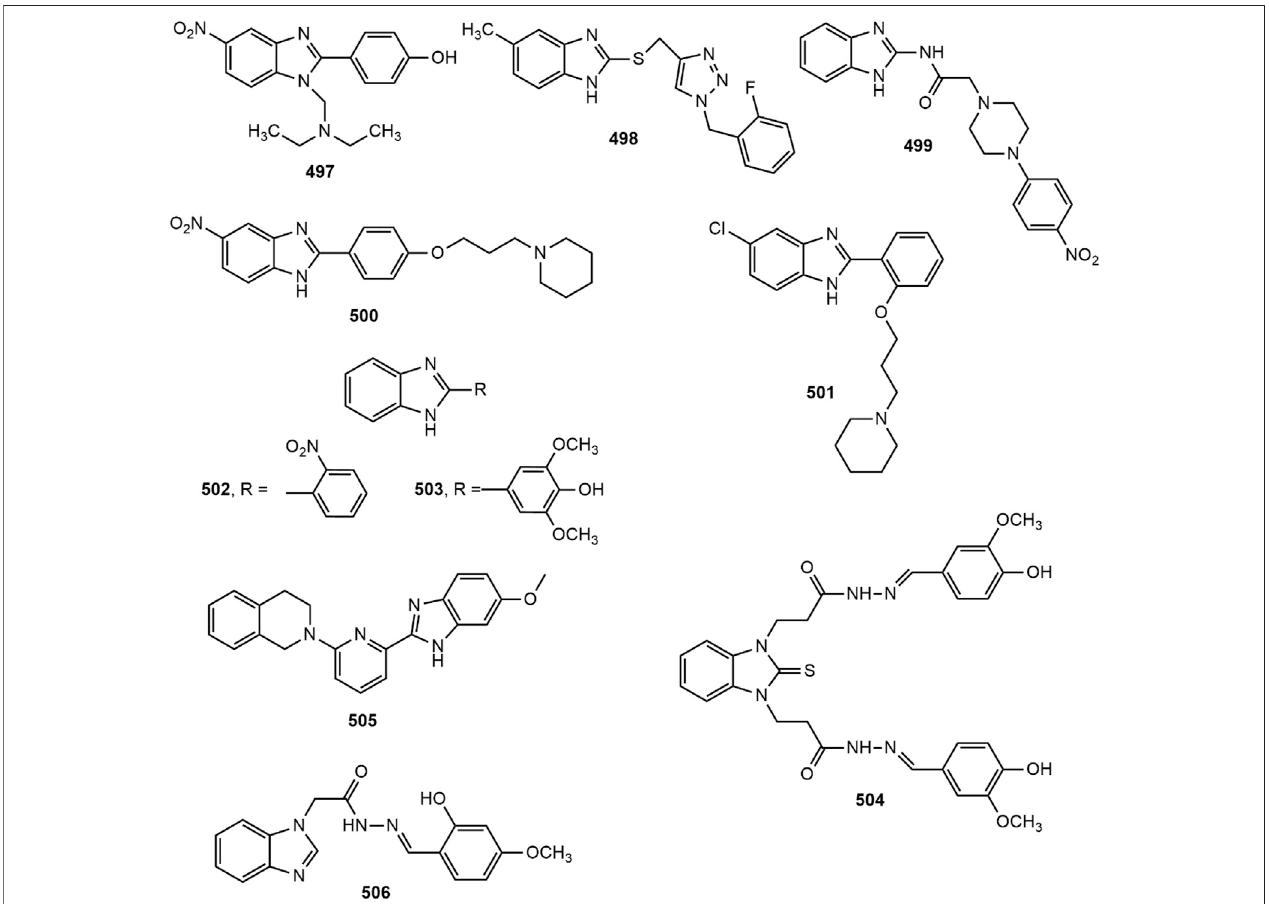
FIGURE 20 | Benzimidazole derivatives as neuro-protective